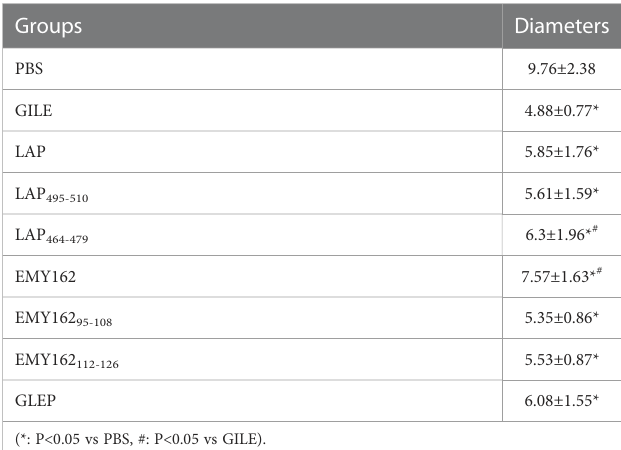
TABLE 1 Maximum diameters of cysts